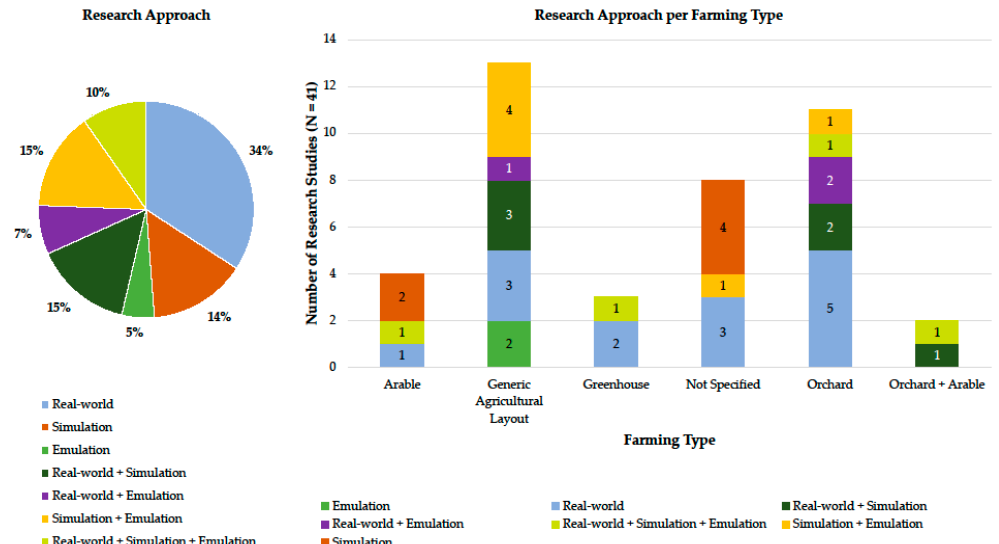
Figure 1. Publications per applied research analysis approach (pie chart on the left); and distribution of the reviewed publications based on the elaborated research analysis approach per farming type (bar chart on the right).